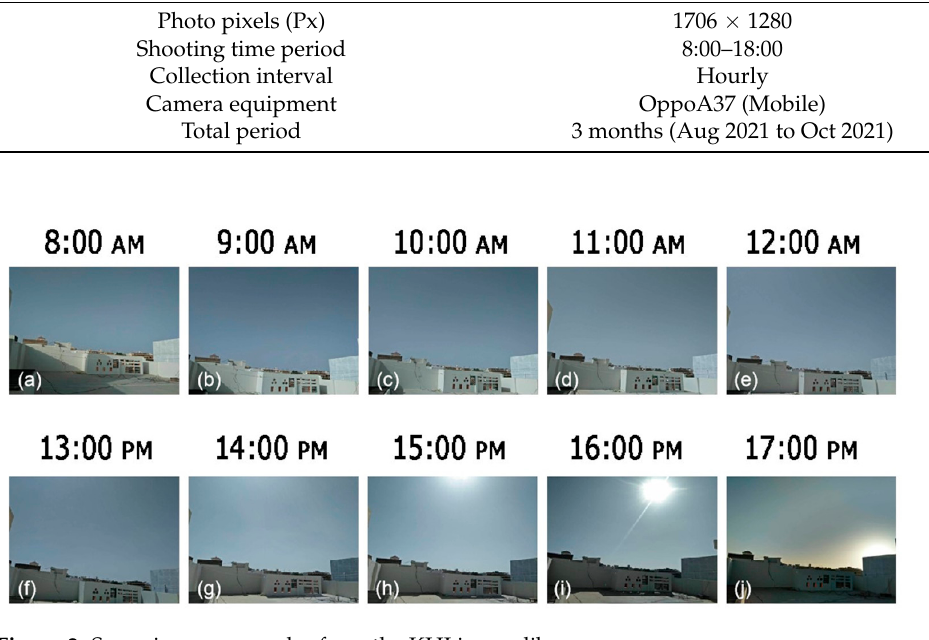
Table 1. Information about the image acquisition process.